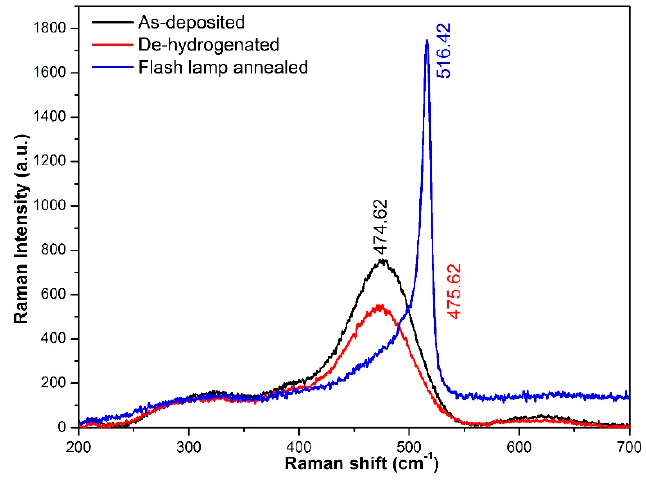
Figure 10. Raman spectra of as-deposited, de-hydrogenated, and flash lamp annealed PECVD silicon thin films.